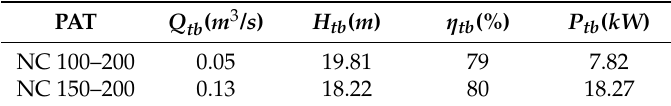
Table 1. Characteristics of micro turbines used. PAT—pump used as